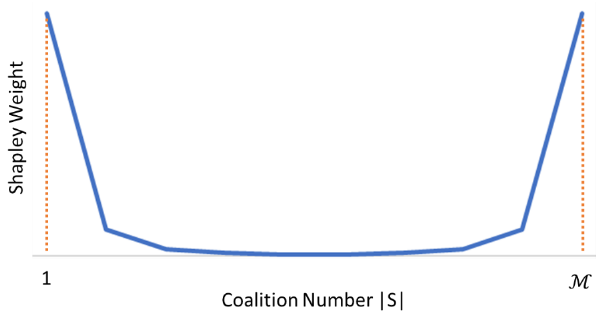
Figure 1. Typical U-shaped distribution of Shapley weights of coalitions of predictors.